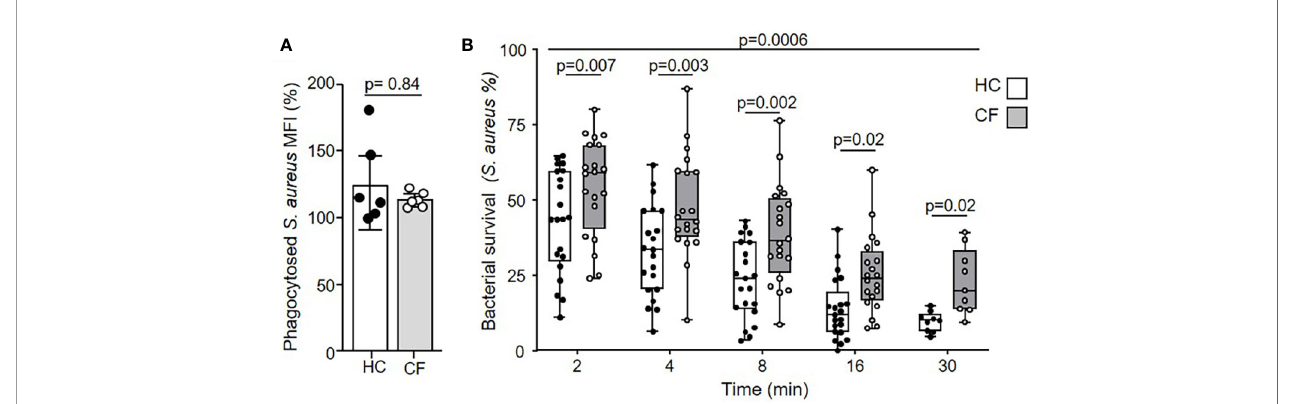
FIGURE 1 | Impaired microbicidal activity of neutrophils from PWCF. (A) Phagocytosis of FITC labelled S. aureus was assessed by fl ow cytometry and expressed as mean fl uorescence intensity (MFI). Healthy control (HC) and neutrophils of PWCF ( Phe508del single copy) demonstrated equal levels of phagocytosis (n = 6 donors per group, paired t test). (B) Killing of S. aureus (0.5 x 10 7 CFU/ml) by HC neutrophils was compared to CF cells donated by PWCF homozygous for the Phe508del mutation Killing rates between HC and CF neutrophils were signi fi cantly different (p = 0.0006) and reduced at each time point (n = 7 subjects per group, linear mixed effects model with post-hoc Holm-S ̌ ı ́ da ́ k